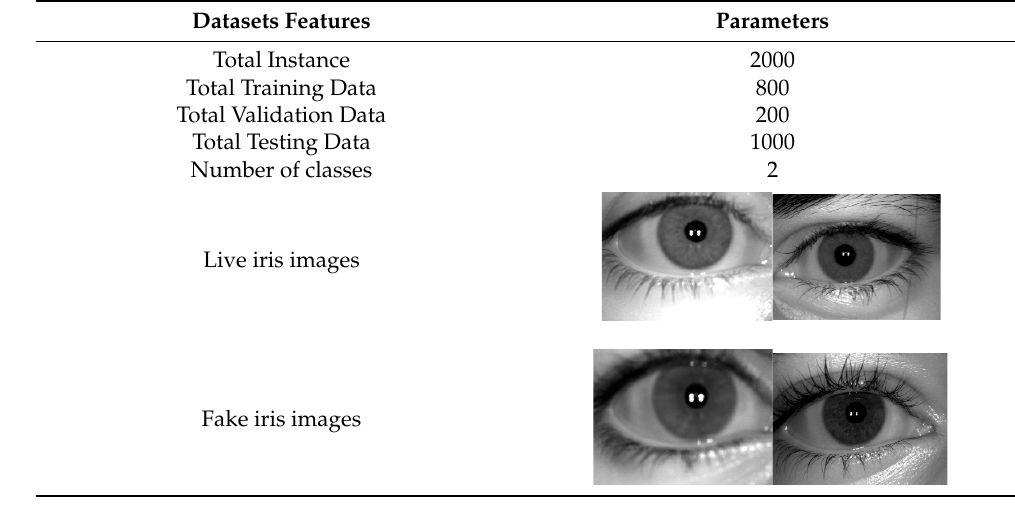
Table 2. IIITD contact lens iris dataset description.